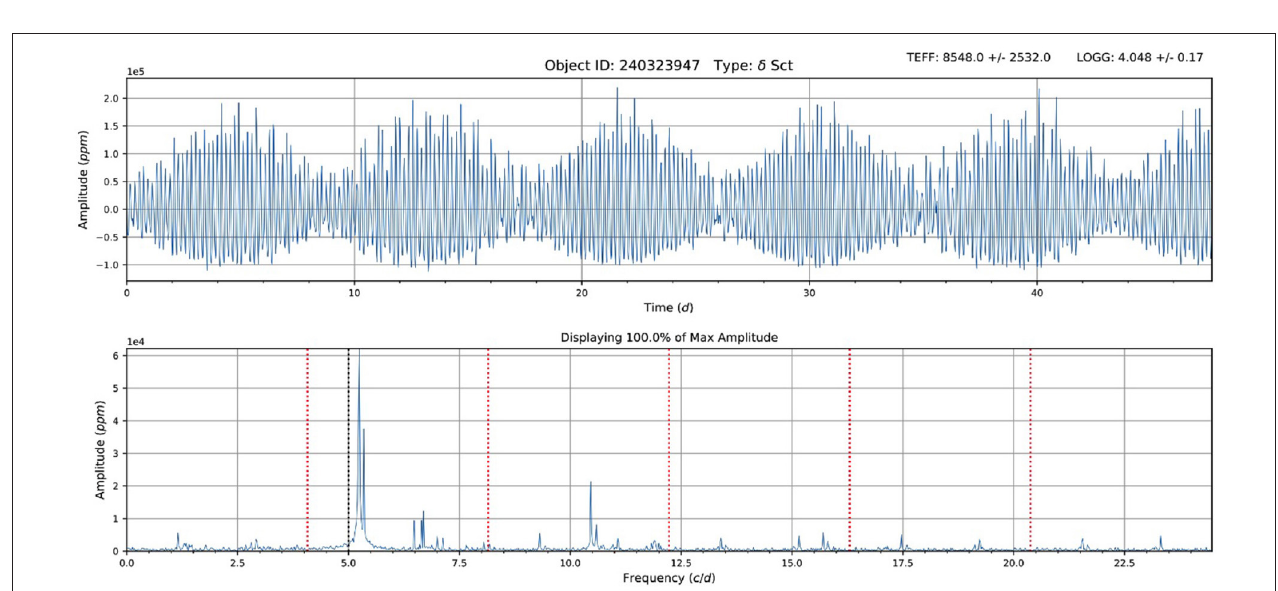
FIGURE 5 | Light curve (Top) and amplitude spectrum (Bottom) for candidate with the largest number of δ Sct-type frequencies (over 30) visible by eye, EPIC 212792450, observed during C6.